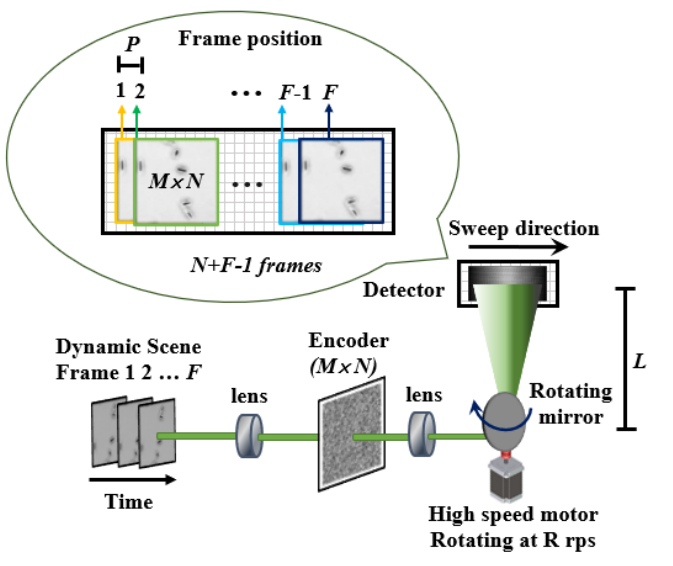
Figure 1. Configuration and operation principle of the proposed compressive coded rotating mirror (CCRM) camera